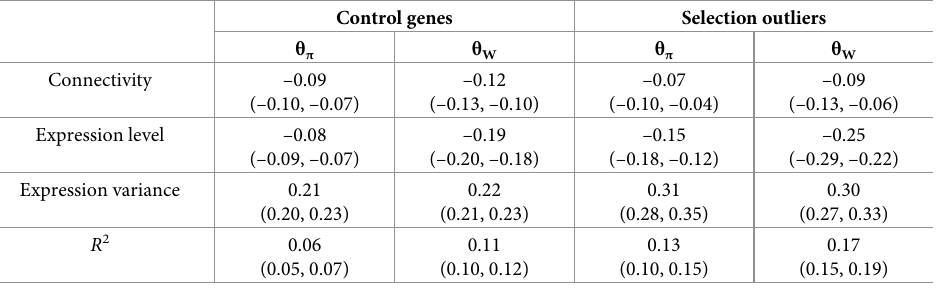
Table 1. The relationship between expression features and genetic diversity. Shown are coefficients from multiple linear regression models and their 95% CIs. Last row shows the total variance explained by each model. Control